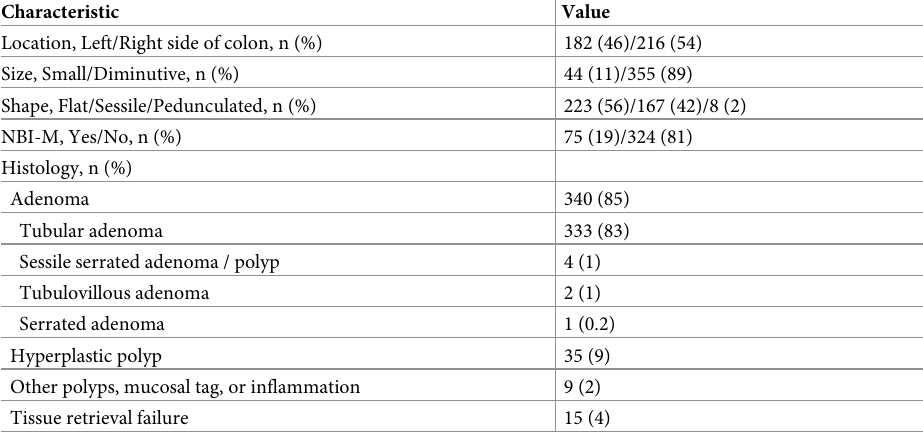
Table 2. Baseline characteristics of polyps (n = 399). Characteristic Value Location, Left/Right side of colon, n (%) 182 (46)/216 (54) Size, Small/Diminutive, n (%) 44 (11)/355 (89) Shape, Flat/Sessile/Pedunculated, n (%) 223 (56)/167 (42)/8 (2) NBI-M, Yes/No, n (%) 75 (19)/324 (81)